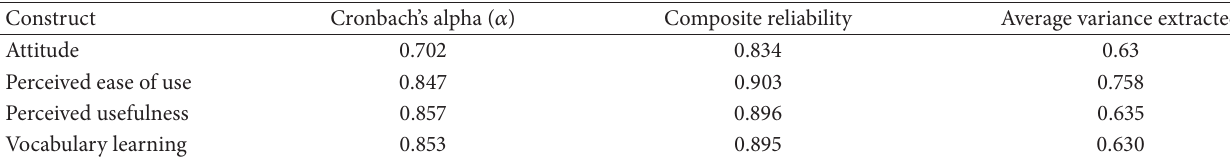
Table 3: Results of the measurement model.